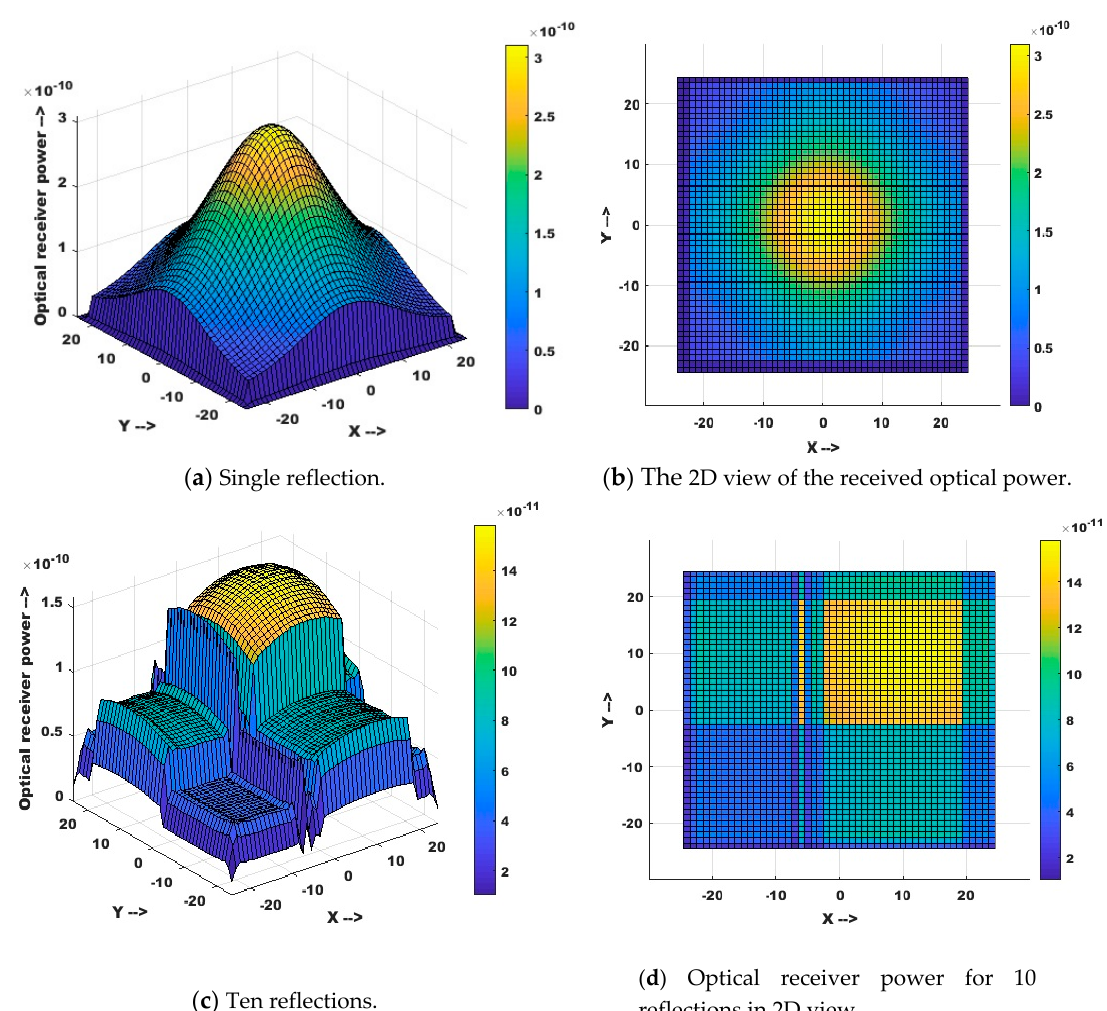
Figure 2. Analysis of a single reflection and 10 reflections.